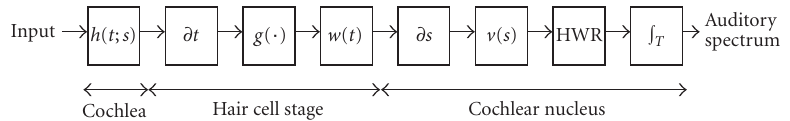
Figure 3: Mathematical model of the early auditory system consisting of filtering in the cochlea (analysis stage), conversion of mechanical displacement into electrical activity in the IHC (transduction stage), and the lateral inhibitory network in the cochlear nucleus (reduction stage) [1].